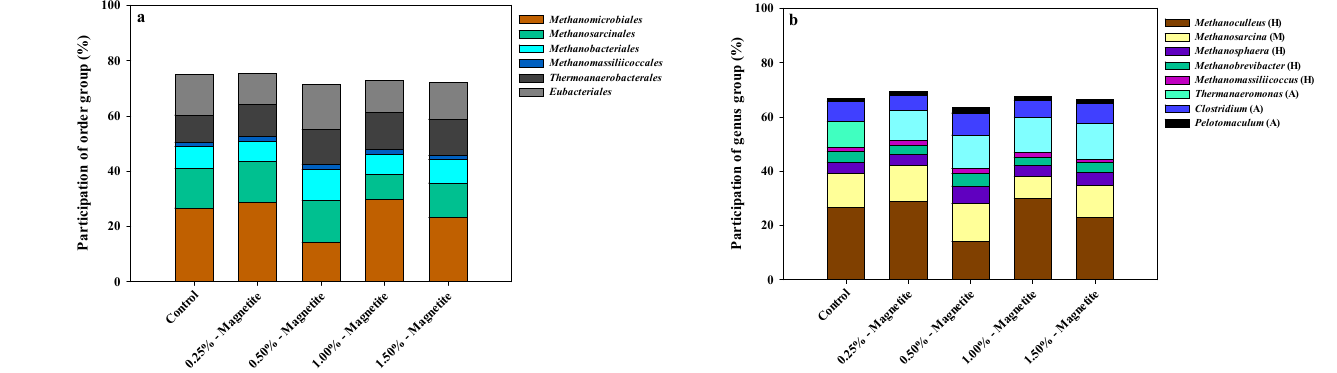
Figure 3. Taxonomic compositions of methanogens at the order level ( a ) and genus level ( b ) in the group treated with the additive zero-valent iron (Fe 0 ), as retrieved from pyrosequencing (H, M, and A denote hydrogenotrophic methanogen, mixotrophic methanogen, and acidogenic bacteria, respectively).